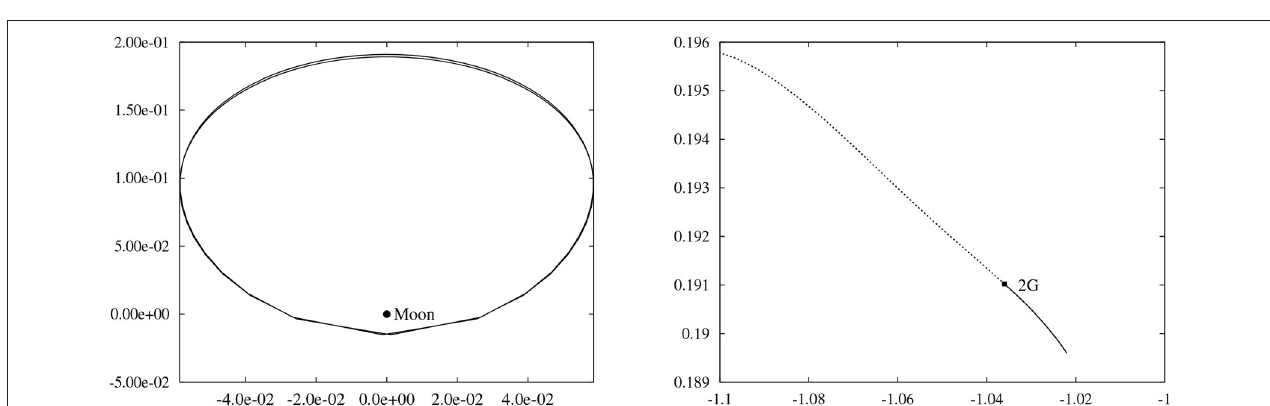
FIGURE 8 | Approximation of order 64 of the stable (dashed) unstable (solid) manifolds of L 1 , L 2 and L 3 . Horizontal axis x . Vertical y .